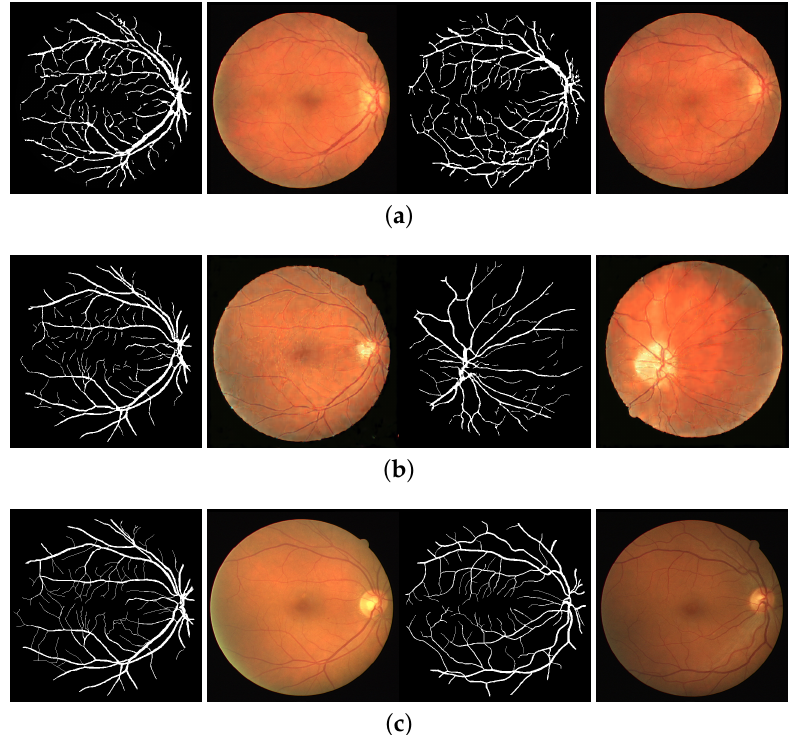
Figure 6. Examples of real and generated DRIVE images. ( a ) Generated DRIVE images with our two-step method; ( b ) Generated DRIVE images with the single-step method; ( c ) Real DRIVE images.